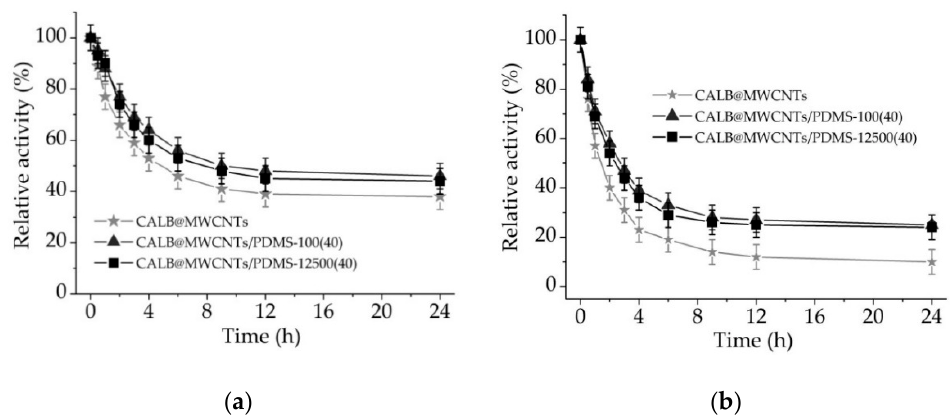
Figure 8. Effect of ( a ) 5% Triton X-100 solution and ( b ) 0.5 M NaCl solution on the relative activity of lipase immobilized onto P-MWCNTs and MWCNTs/PDMS